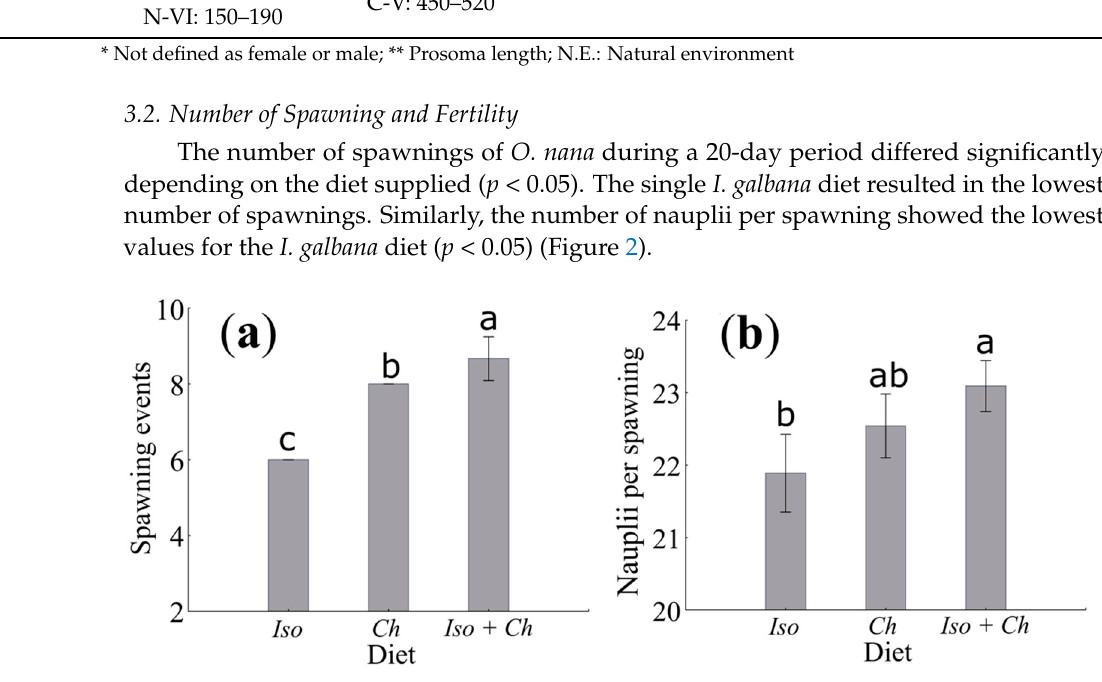
Figure 2. Oithona nana fed with single and mixed diets during 20 days of evaluation. ( a ) Number of spawnings. ( b ) Fertility or number of nauplii per spawning. Descriptive error bars shown as average ± Standard Deviation. The letters above each bar indicate the significant differences (a > b > c, n = 3, p < 0.05). Table 4. Oithona nana length comparison ( μ m) fed with experimental microalgae or natural food, in the different develop ‐ ment stages, nauplii, copepodites, and females and males. Microalgae (×10 3 /mL) Nauplii Copepodite